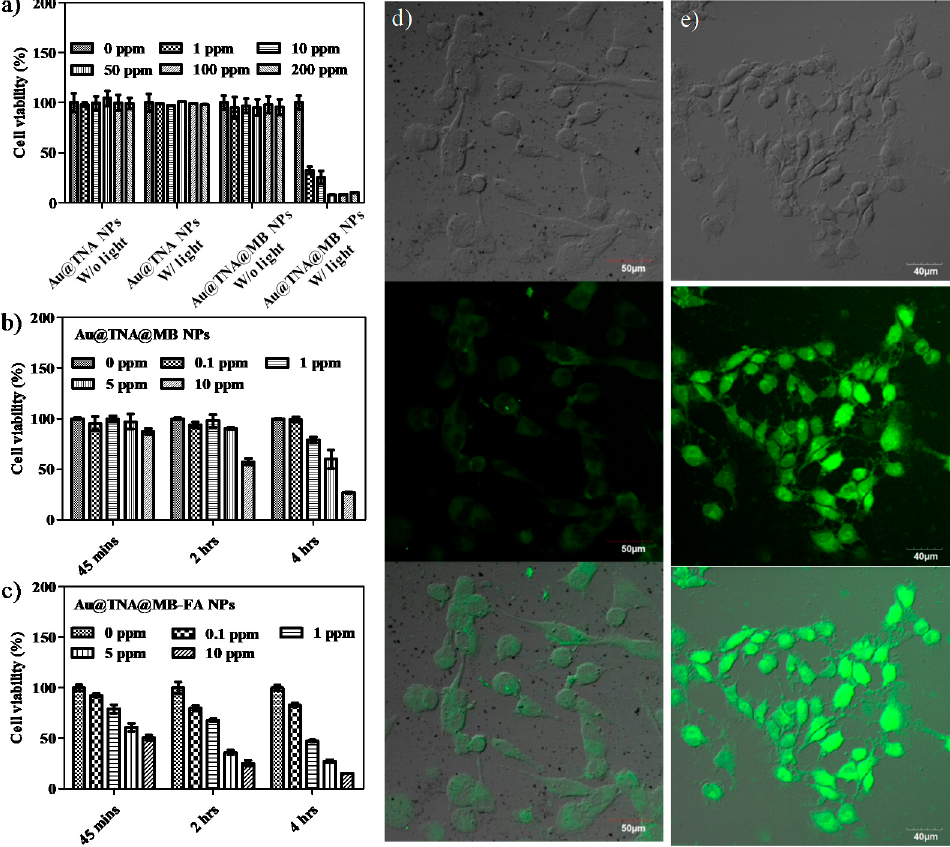
Figure 5. MTT assays of ( a ) T24 cells cotreated with particles for 24 h: Au@TNA, Au@TNA@MB, Au@TNA plus 650 nm light, and Au@TNA@MB plus 650 nm light. T24 cells cotreated with ( b ) Au@TNA@MB NPs and ( c ) folic acid (FA)-conjugated Au@TNA@MB NPs for 0.75–4 h upon excitation at 650 nm. Photodynamic therapy (PDT) treatment of T24 cells stained with DCFH-DA dye by using ( d ) Au@TNA@MB NPs and ( e ) FA-conjugated Au@TNA@MB NPs. Top: bright field image, middle: fluorescent image, and bottom: merged image. The 650 nm laser power density was 125 mW/cm 2 .